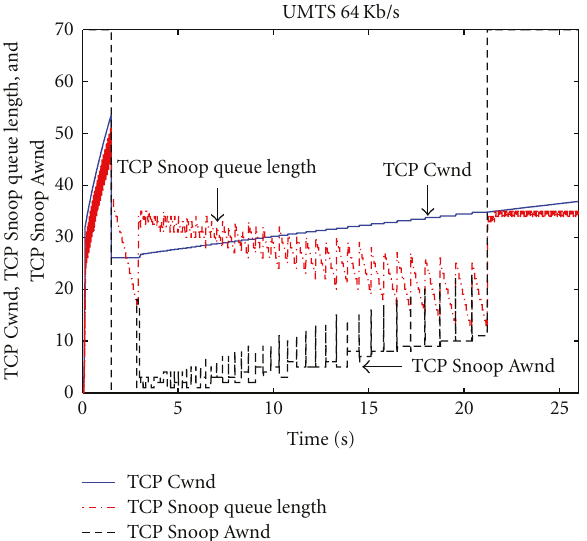
Figure 9: The variations of local queue length and advertised window size (UMTS data rate 64Kb/s, local queue length 35 after